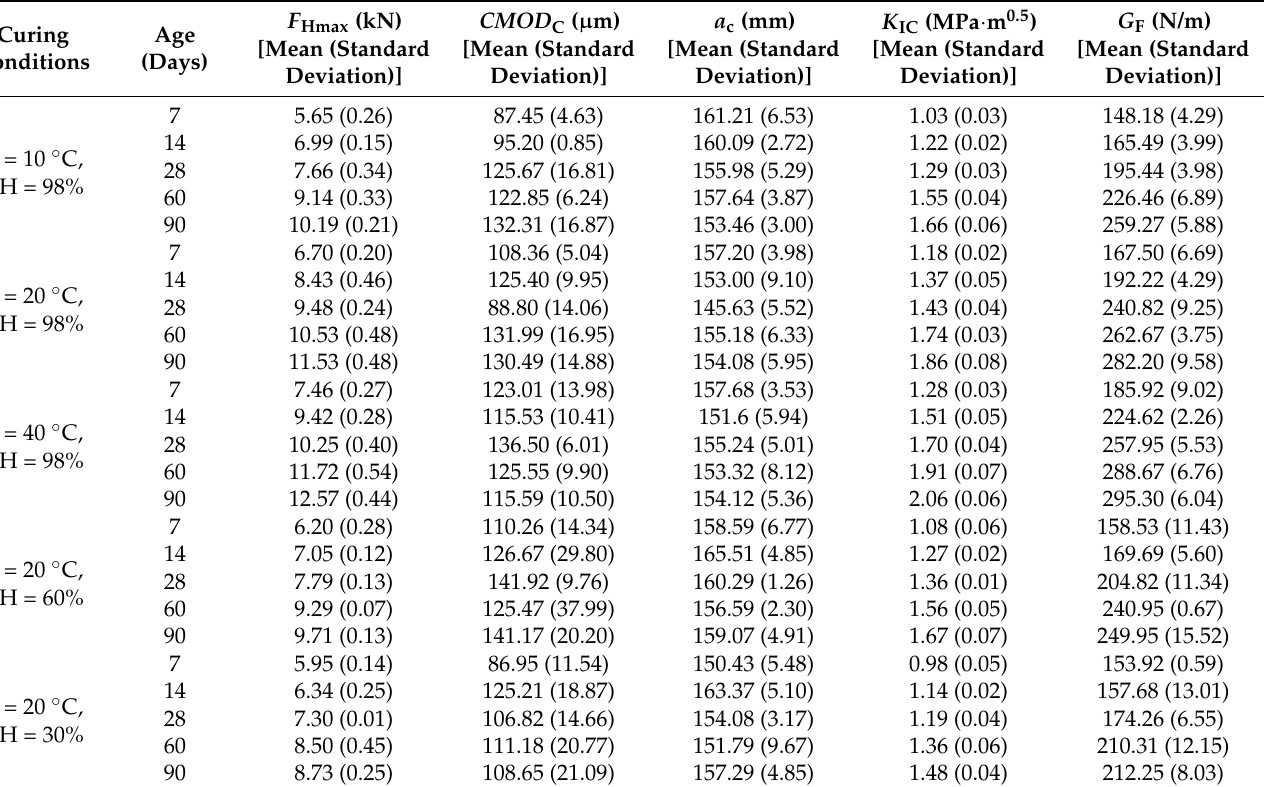
Table 5. Fracture parameters of gallery concrete at different ages and under different curing conditions.